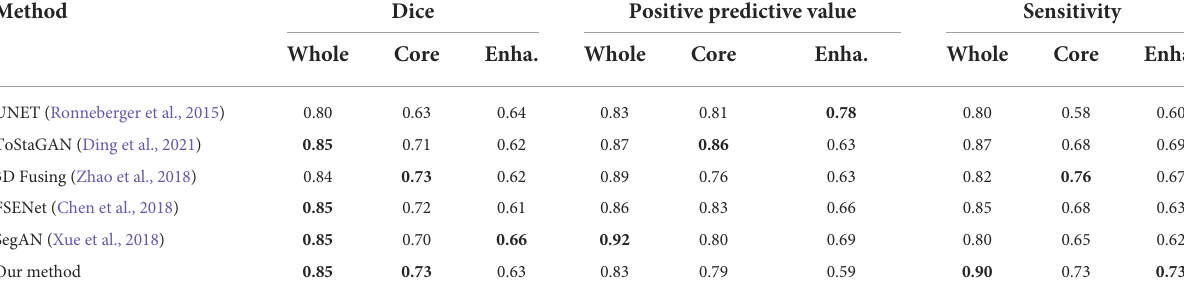
TABLE 6 Performance of some methods on BRATS2015 testing